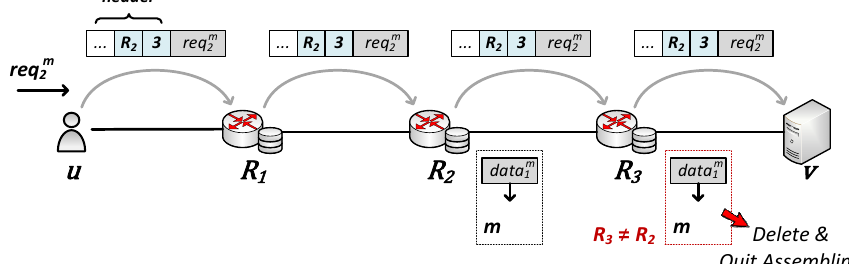
Figure 7. Forwarding process of subsequent request packets.